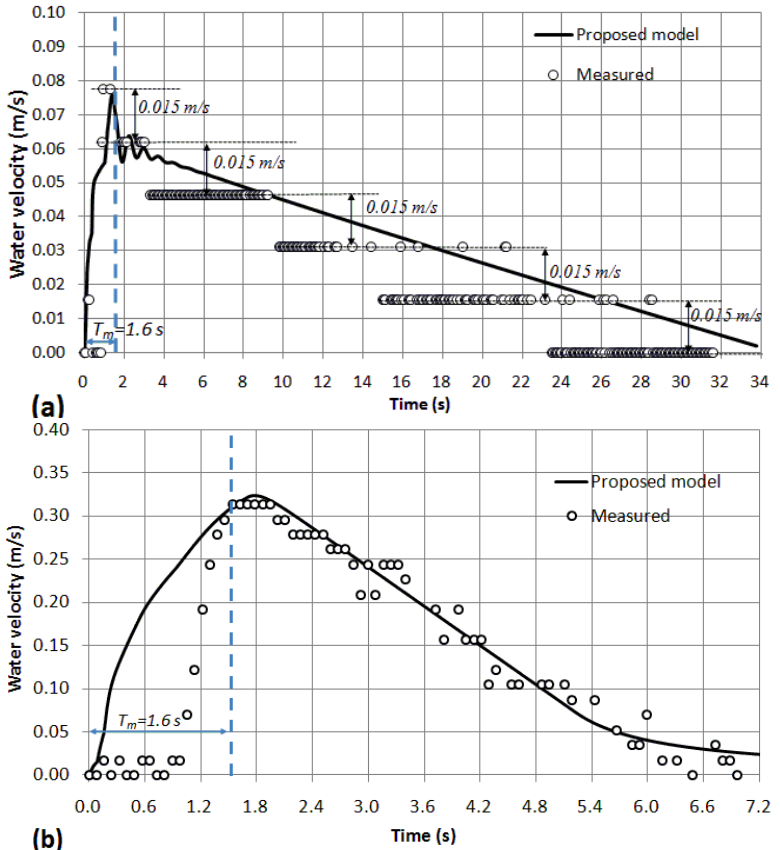
Figure 8. Comparison of water velocity between computed and measured values: ( a ) Test No. 3 (air valve S 050); ( b ) Test No. 8 (air valve D